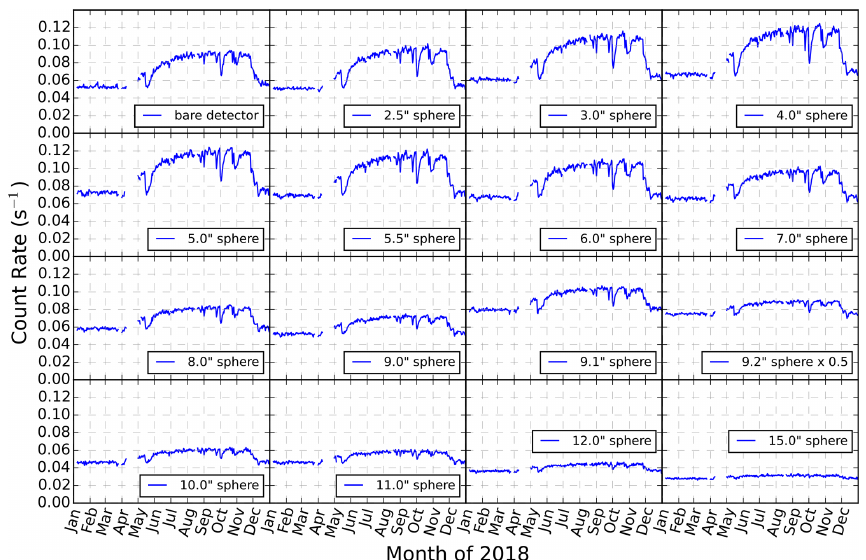
Figure 7. Measured daily count rates of the ERBSS proportional counters at UFS in 2018. Note that the count rates of the 9.2in. sphere are divided by 2 to fit into the scale.